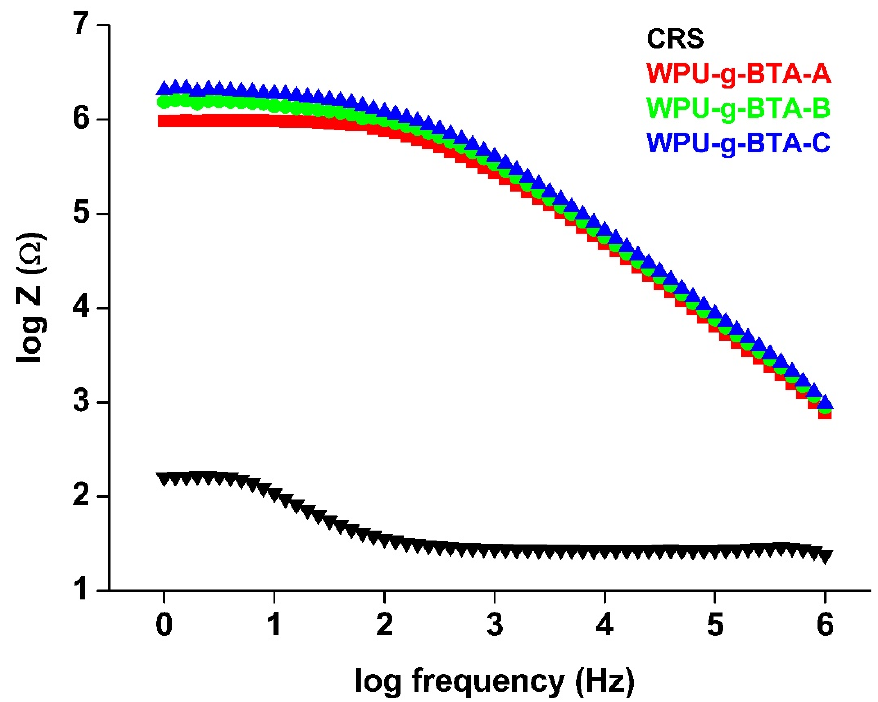
Figure 8. BODE plots for raw CRS electrode and CRS electrode coated with WPU − g − BTA − A, WPU − g − BTA − B, and WPU − g − BTA − C in 3.5 wt% NaCl (aq) .